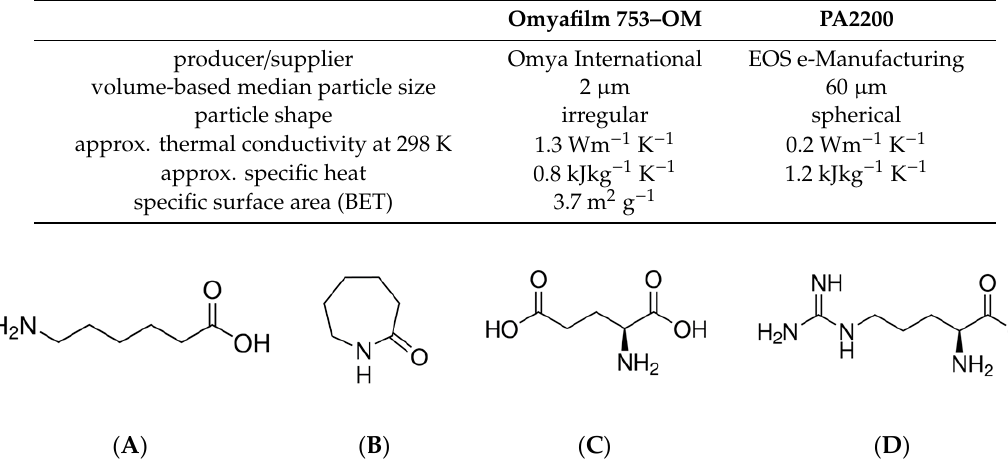
Figure 1. Molecular structure of ( A ) 6-amino hexanoic acid; ( B ) ε -caprolactam; ( C ) glutamic acid and ( D ) L -arginine. Table 1. Material specification.